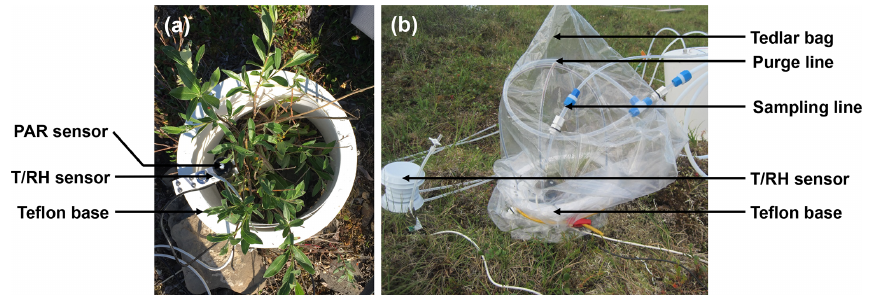
Figure 2. Photographs of a surface enclosure experiment setup at Toolik Field Station, Alaska. (a) The first step of the installation consisted of positioning the Teflon base around the vegetation of interest along with temperature ( T ), relative humidity (RH), and photosynthetically active radiation (PAR) sensors. (b) The second step consisted of positioning the Tedlar ® bag around the base. The bag was connected to a purge-air and a sampling line. An additional T/ RH sensor was also positioned outside the